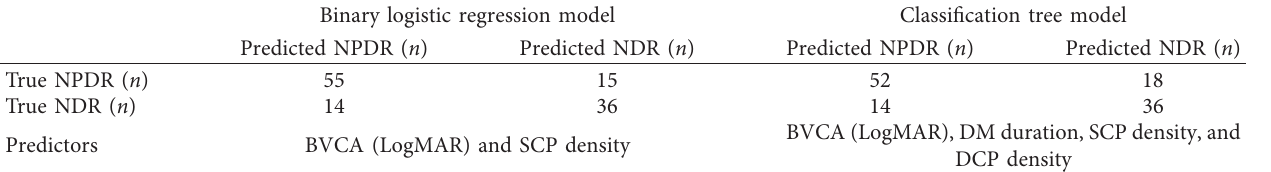
Table 3: Validation outcomes and predictors in two models.